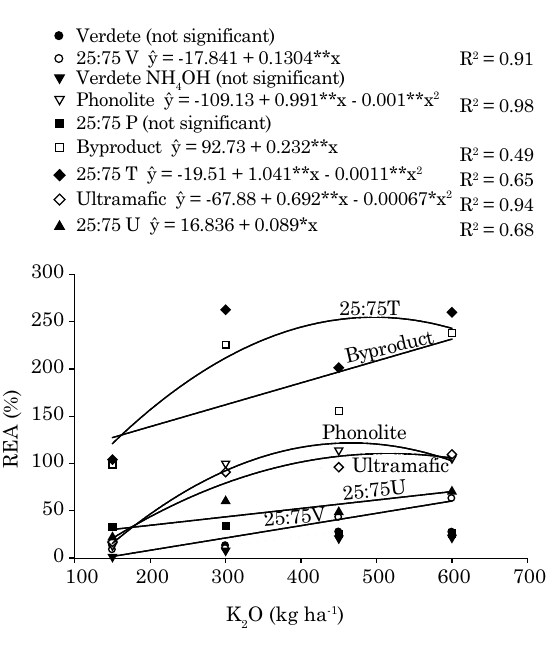
Figure 8. Relative Agronomic Efficiency Index (RAE) of the multi-nutrient sources based on K accumulation in Brachiaria shoots, as affected by the applied rates.